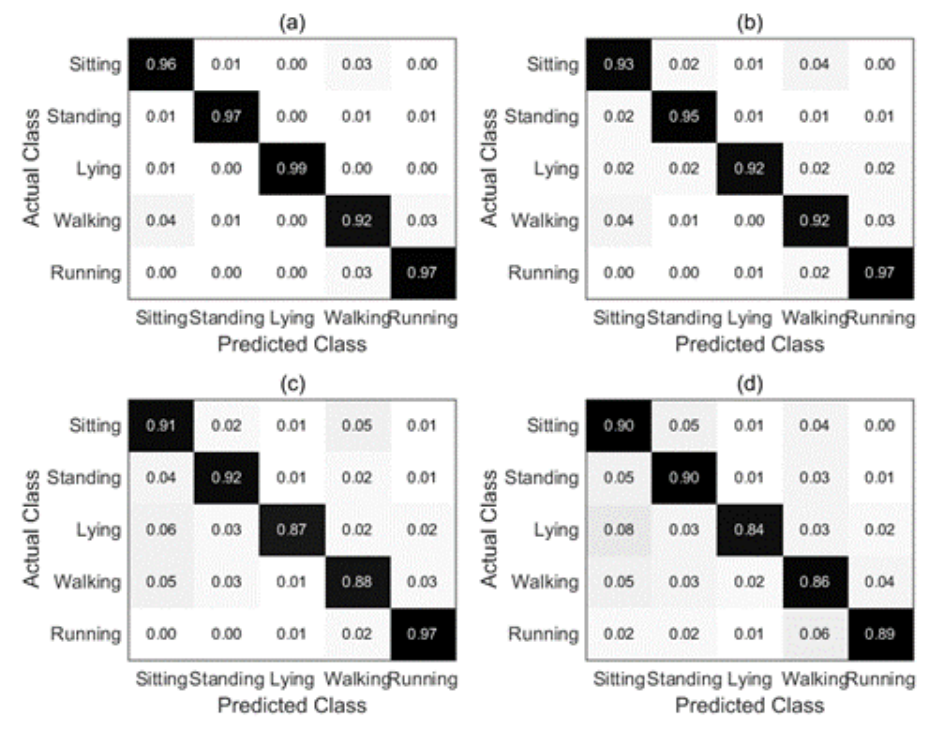
Figure 12. Confusion matrices comparison of different combination strategies for subject 1 in DSAD dataset. ( a ) GDM fusion; ( b ) GA; ( c ) WA; ( d ) MV. Table 6. The performance comparison of different fusion strategies for four subjects in DSAD dataset.